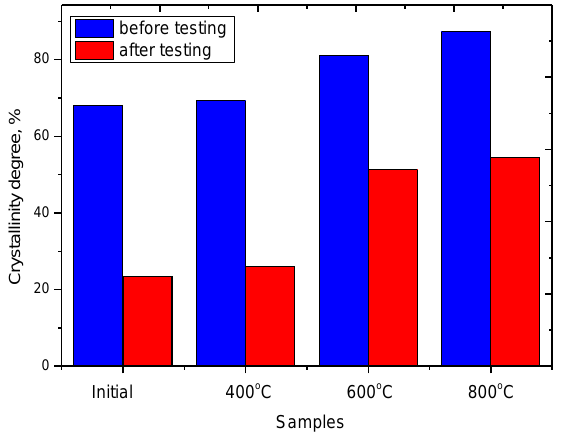
Figure 10. The dynamics of changes in the degree of crystallinity before and after life tests.